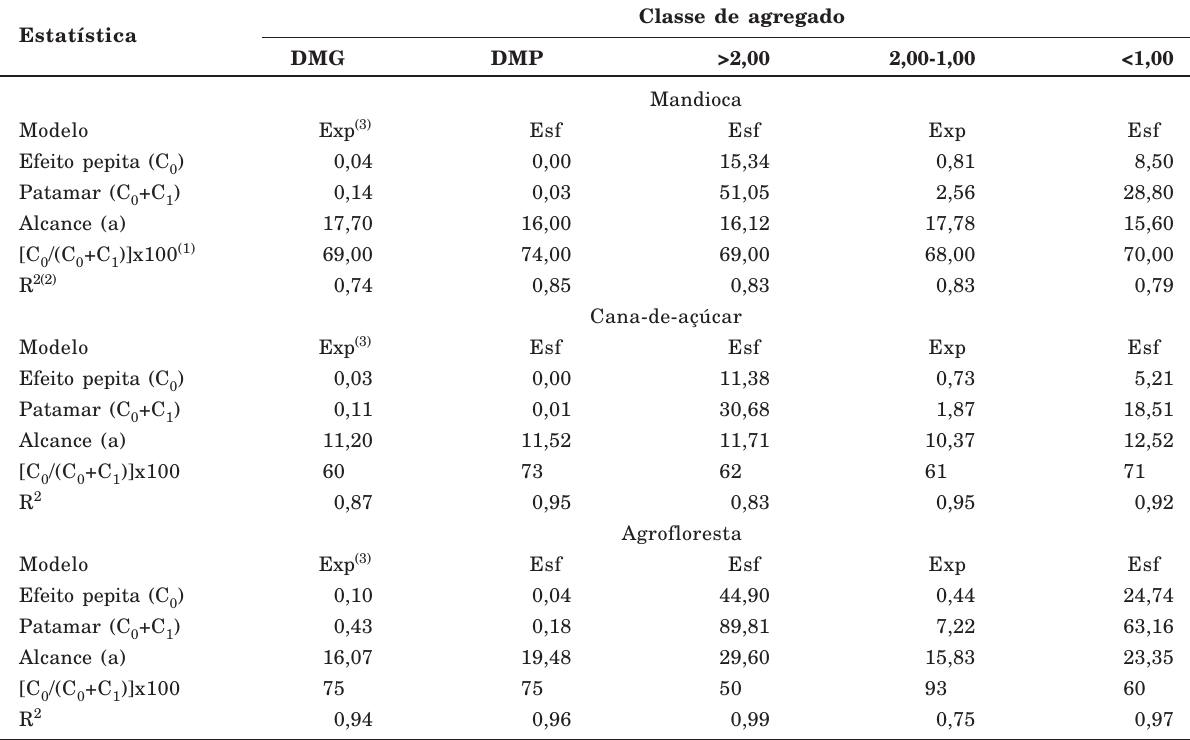
Quadro 4. Modelos e parâmetros estimados dos semivariogramas das variáveis DMG e DMP e classes de agregados na profundidade de 0,0- 0,10 m, em áreas sob diferentes usos na região sul do